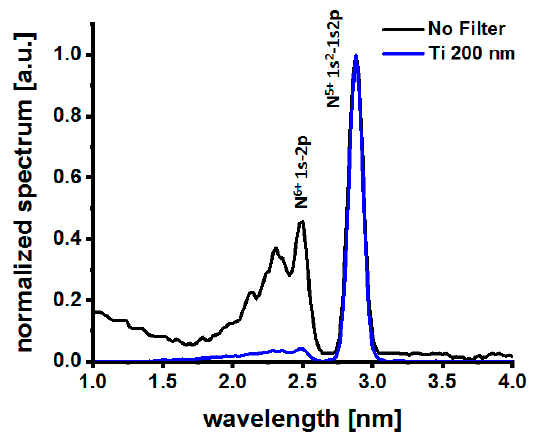
Figure 8. N 2 plasma emission in the “water window” spectral range, unfiltered (black line) and filtered with a 200 nm thick Ti filter (blue line).